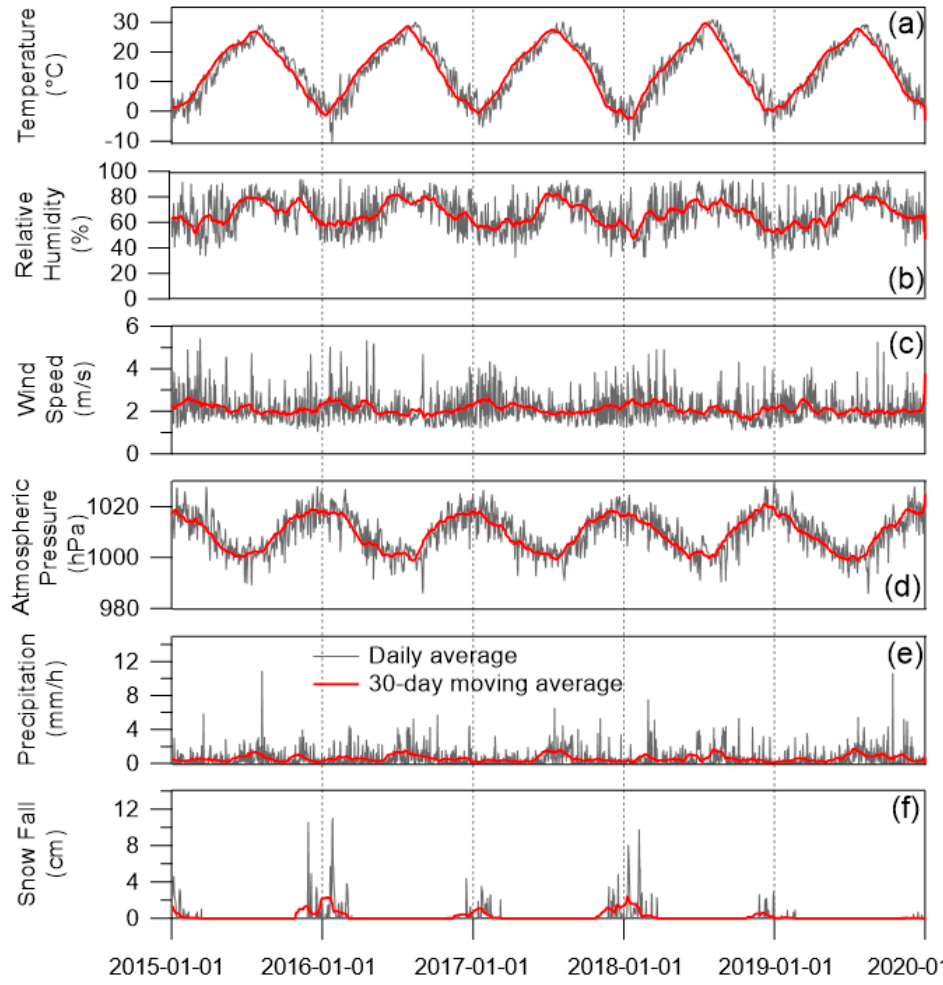
Figure 4. Daily average with 30 − day moving average for ( a ) Temperature, ( b ) Relative humidity, ( c ) Wind speed, ( d ) Atmospheric pressure, ( e ) Precipitation, and ( f ) Snow fall.